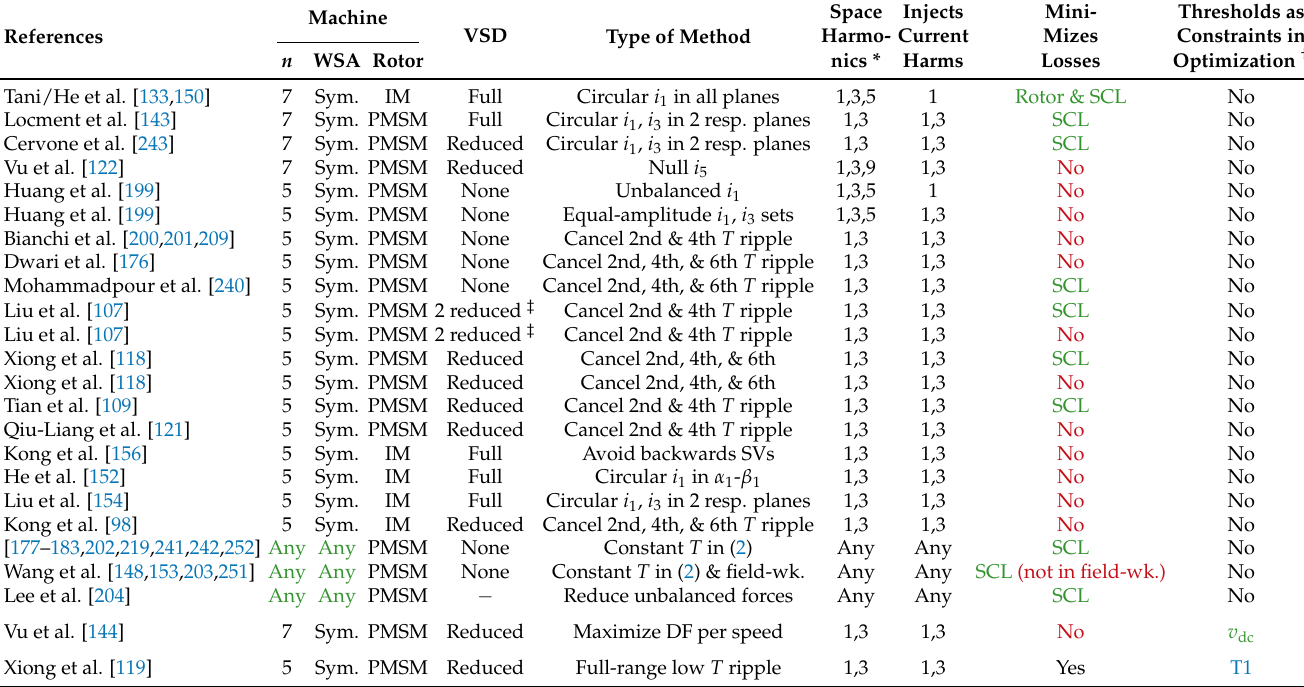
Table 14. Methods for generating current references under phase OCs reducing torque ripple due to space harmonics (Section 3.5.2) in multiphase applications in the